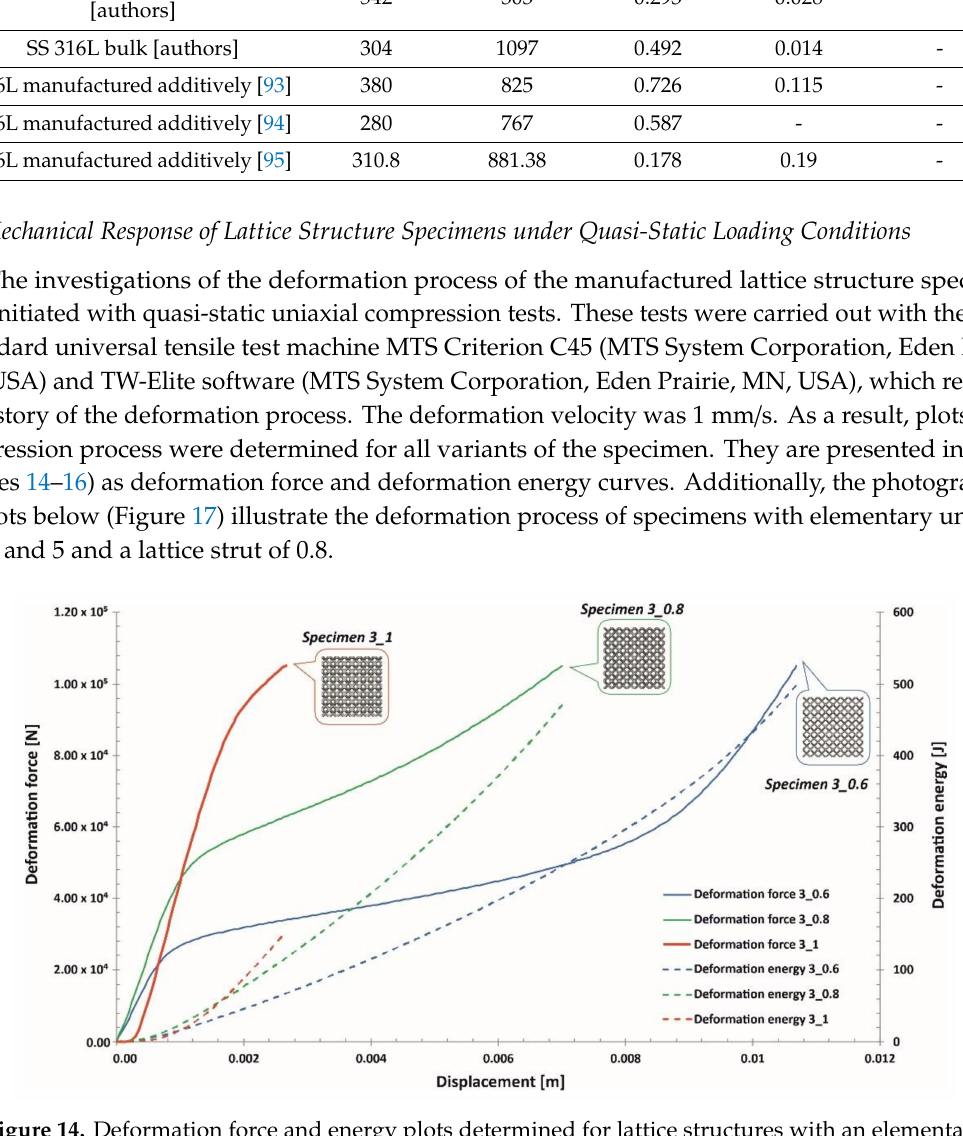
Figure 14. Deformation force and energy plots determined for lattice structures with an elementary unit cell equal to 3